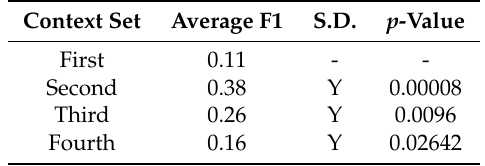
Table 12. ISFB Dataset—Training Context Combinations.